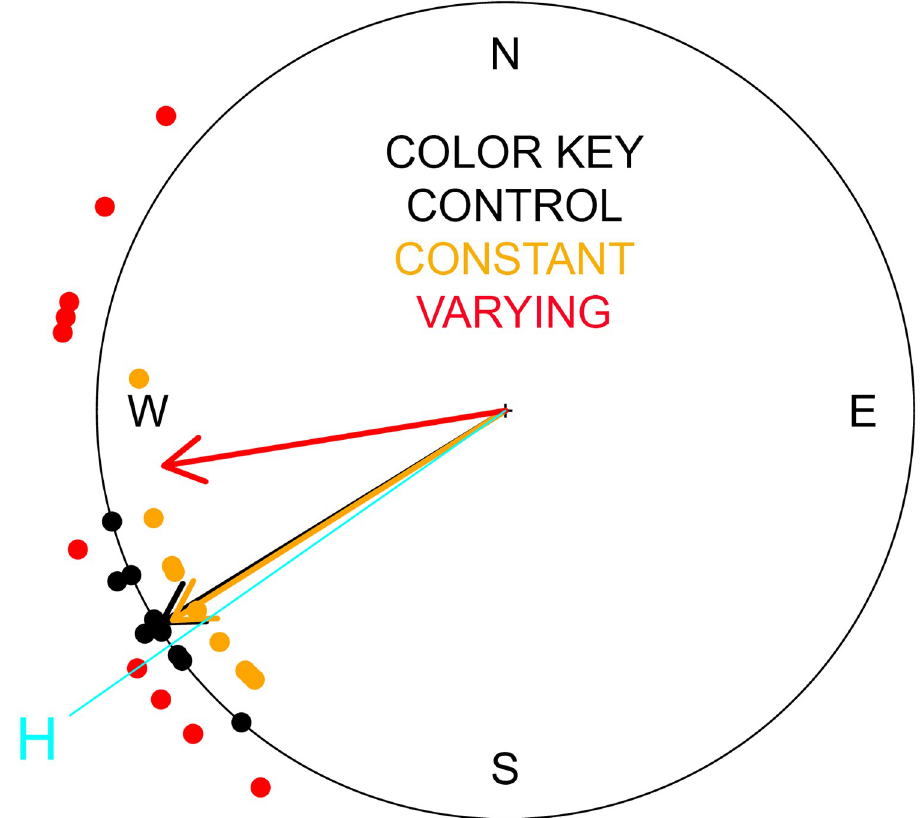
Fig 1. Vanishing bearings of pigeons from the first release along with the mean vector for each group. Black = control; Orange = exposed to constant magnetic field in MRI; Red = exposed to varying magnetic field from scanning sequences. Home direction is marked with the light blue line and “H”.